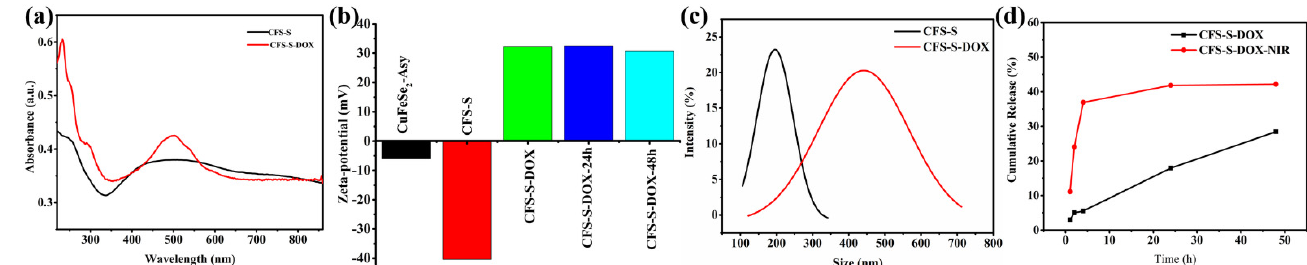
Figure 3. ( a ) UV–Vis spectra before and after CFS-S loading DOX. ( b ) Zeta potential of CuFeSe 2 NS as-synthesized, CFS-S, CFS-S-DOX, and CFS-S-DOX after laser irradiation and then being held at room temperature for 24 h and 48 h. ( c ) Hydrodynamic diameters of CFS-S (black) and CFS-S-DOX (red). ( d ) Dox release profile of CFS-S-DOX with or without 1.0 W cm -2 808 nm laser (times: 1 h, 2 h, 4 h, 24 h, 48 h).